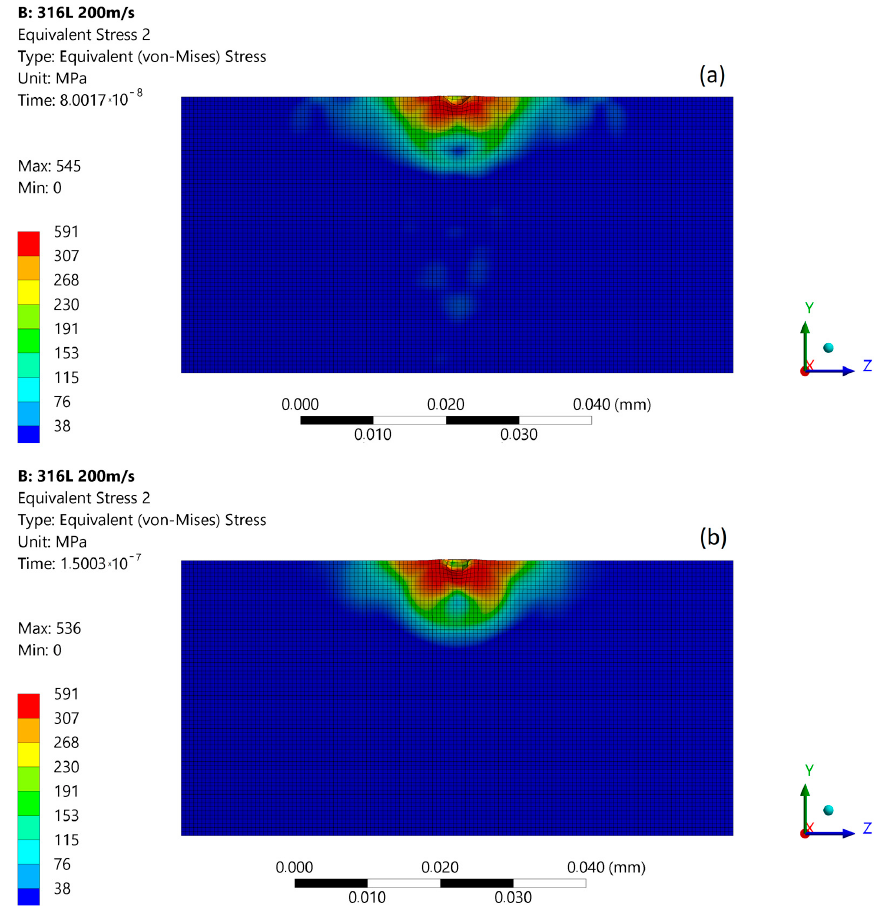
Figure 11. Exceeded yield stress zone (over 307 MPa—red) of 316L stainless steel: ( a ) after first micro ‐ jet impact; ( b ) after subsequent micro ‐ jet impact; at 200 m/s.